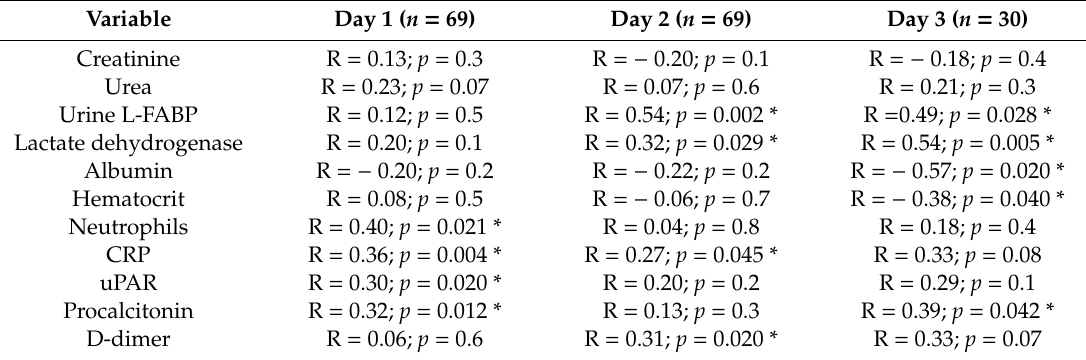
Table 3. Correlations between KIM-1 and the selected laboratory results on days 1, 2, and 3 of the study in the studied patients with acute pancreatitis.